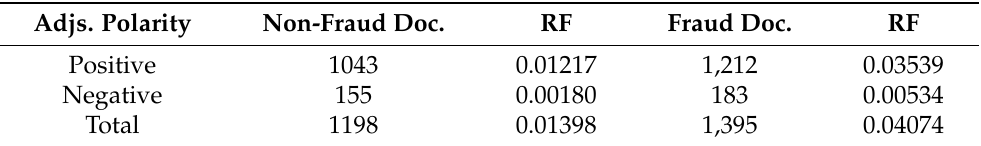
Table 3. Number of occurrences of positive and negative adjectives in fraudster corpus and the relative frequency